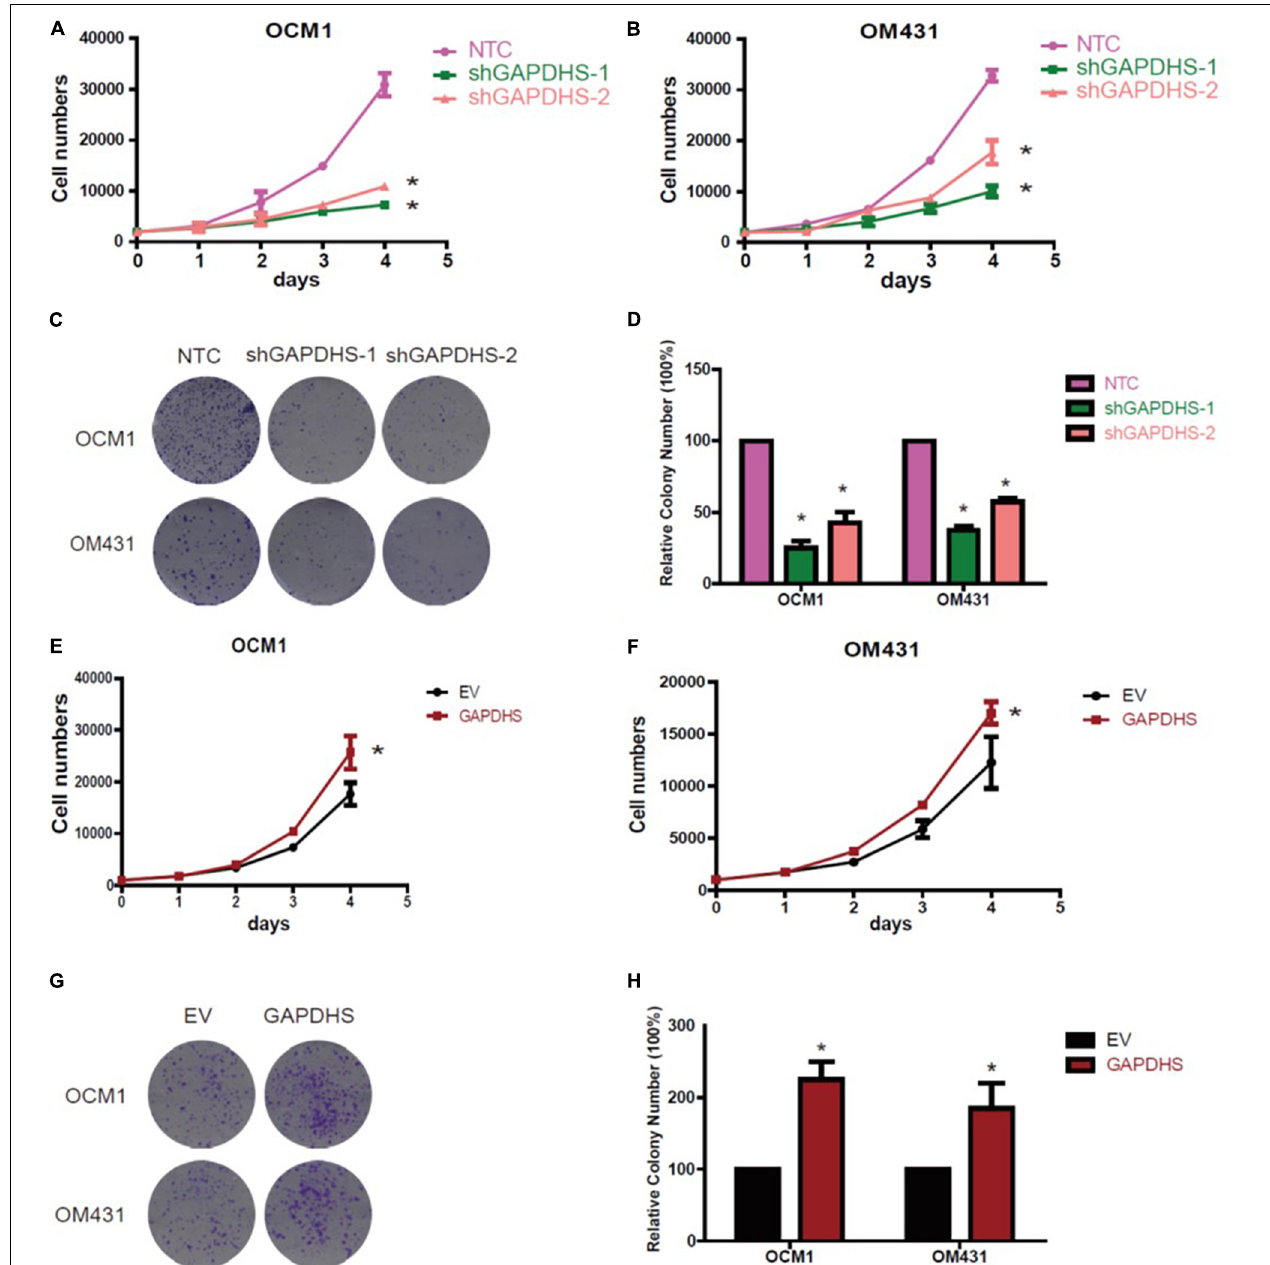
FIGURE 4 | Glyceraldehyde-3-phosphate dehydrogenase (GAPDHS) promotes growth and proliferation in vitro . (A,B) Cell growth of melanoma cells stably expressing non-targeting control (NTC) or two shRNAs (shGAPDHS-1 and shGAPDHS-2) of GAPDHS. (C,D) Colony formation assay to assess the tumor colony forming ability of OCM1 and OM431 cells expressing Non-targeting control (NTC) and two shRNAs (shGAPDHS-1 and shGAPDHS-2) of GAPDHS. (E,F) Cell growth of melanoma cells stably overexpressing control (EV) or GAPDHS. (G,H) Colony formation assay to assess the tumor colony forming ability of OCM1 and OM431 cells overexpressing control (EV) or